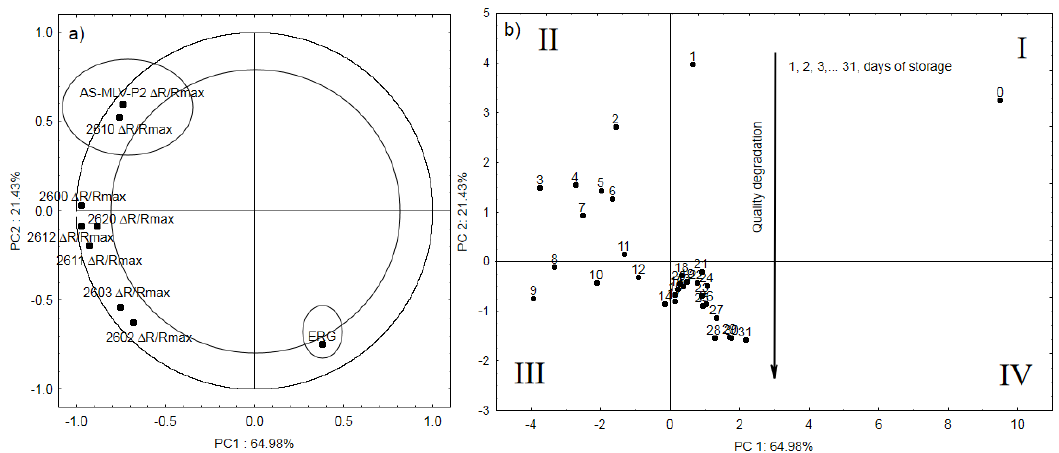
Figure 5. ( a ) location of loading vectors relative to the first two principal components (PC1, PC2) from principal component scores (PC1, PC2) from eight sensors for ∆ R / R max readings and ergosterol obtained eight sensor readings for  R/R max and ergosterol obtained for 31 days of storage; ( b ) plot of two for 31 days of principal component scores (PC1, PC2) from eight sensors for  R/R max readings and ergosterol obtained for 31 days of storage.